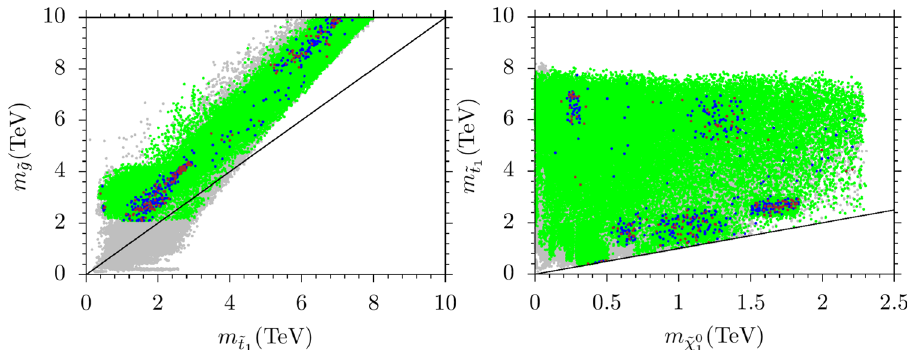
− m Fig. 2 Plots in the m ˜ g − m ˜ t and m ˜ t planes. All points they are allowed by the constraints on the relic abundance of LSP ˜ χ 0 1 1 1 neutralino set by the WMAP and Planck satellites, respectively. The are compatible with the REWSB and LSP neutralino conditions. diagonal lines indicate the mass degeneracy between the displayed Green points satisfy the mass bounds and the constraints from rare particles B − meson decays. Blue and brown points form subsets of green, and